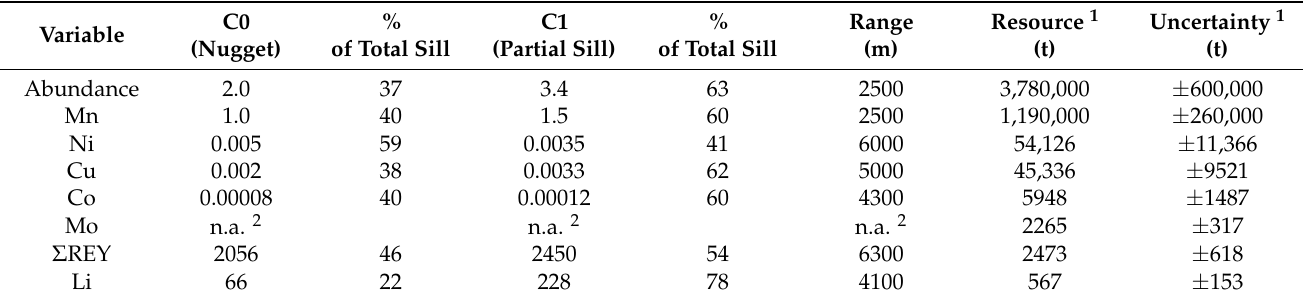
Table 6. Variogram models of PA1-West (241 km 2 ).